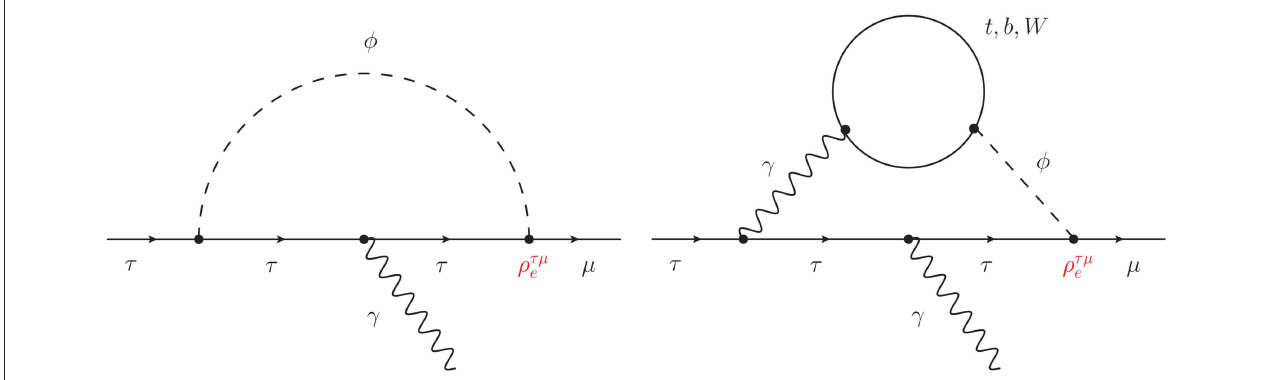
h , H , A . To the left, 1-loop diagrams with neutral Higgs bosons and charged leptons in µγ in the 2HDM. Here φ FIGURE 2 | Most important contributions to τ → = the loop. To the right, 2-loop Barr-Zee diagrams with an internal photon and a third generation quark or a W -boson. The LFV vertex proportional to ρ τµ e is explicitly indicated.